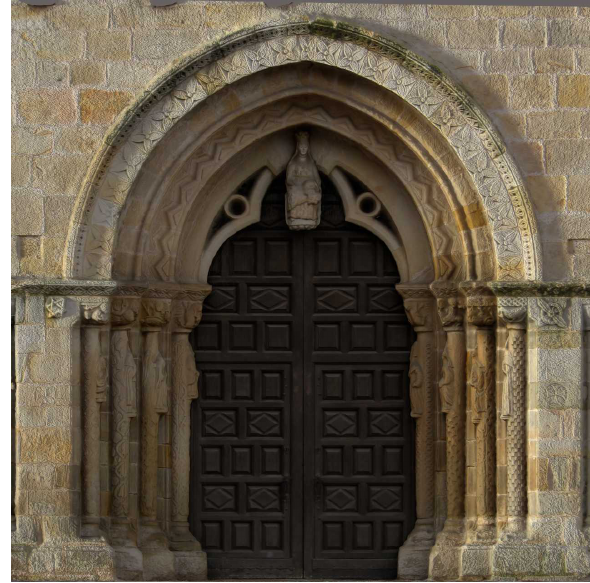
Figure 9: Composition of all the estimated illumination compo- nents of one of the images, diffuse, direct and shadow.